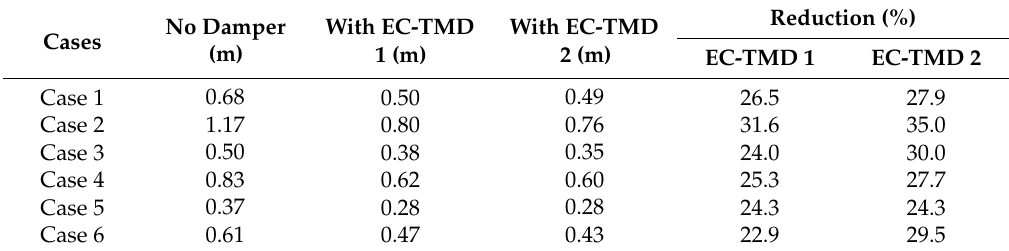
Figure 16. Displacement time histories with 1 and 50 years ’ recurrence periods: ( a ) Class I with 1 year’s recurrence period; ( b ) Class I with 50 years’ recurrence period; ( c ) Class III with 1 year’s recurrence period; ( d ) Class III with 50 years’ recurrence period . Table 7. Peak values of displacements at the tower top for different cases. Table 7. Peak values of displacements at the tower top for different cases.